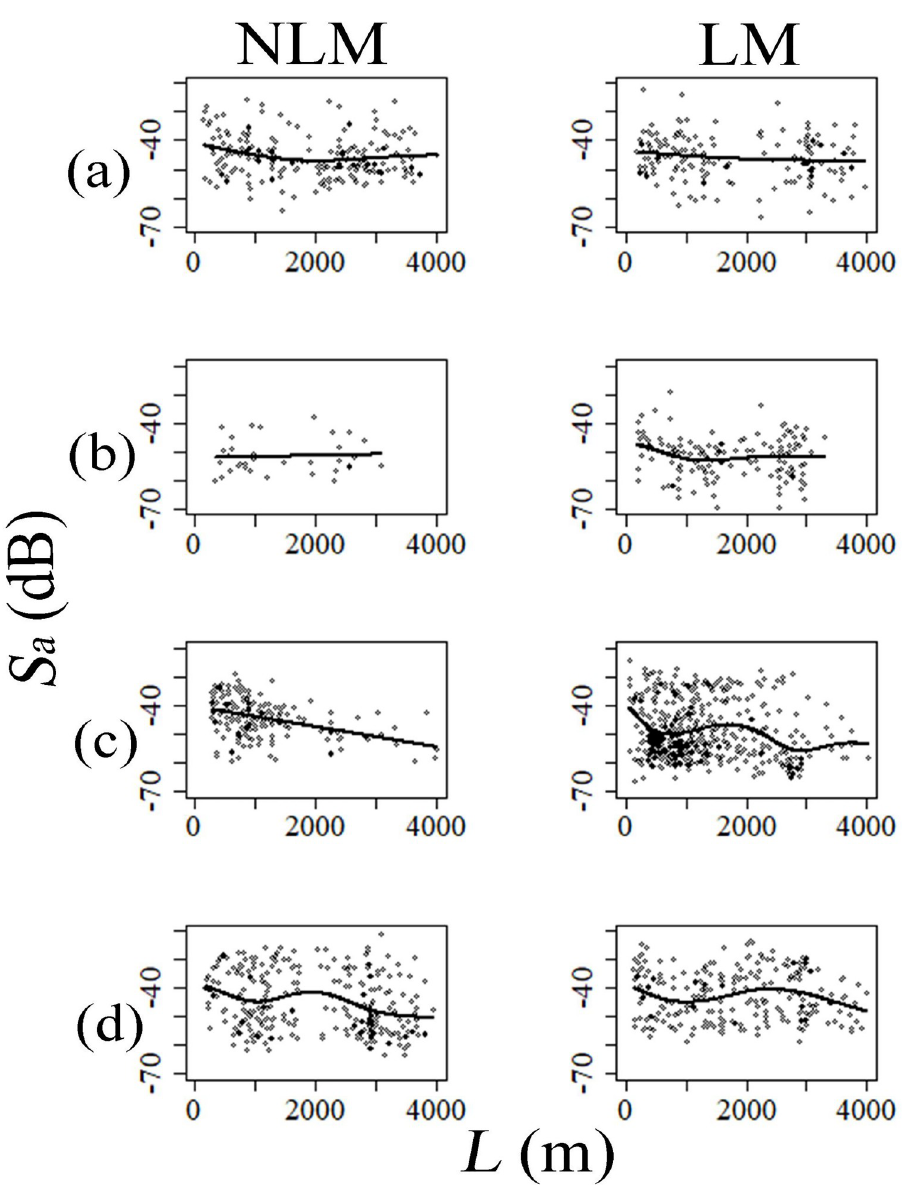
Fig 4. Seasonal variation of fish distribution in horizontal structure expressed as the relationship between Sa (area backscattering strength) and L (distance from shore) based on GAM. The solid line shows the estimated line of fish density ( Sa ). The open circles show the measured value of Sa (a: Summer, b: Autumn, c: Winter, d: Spring).